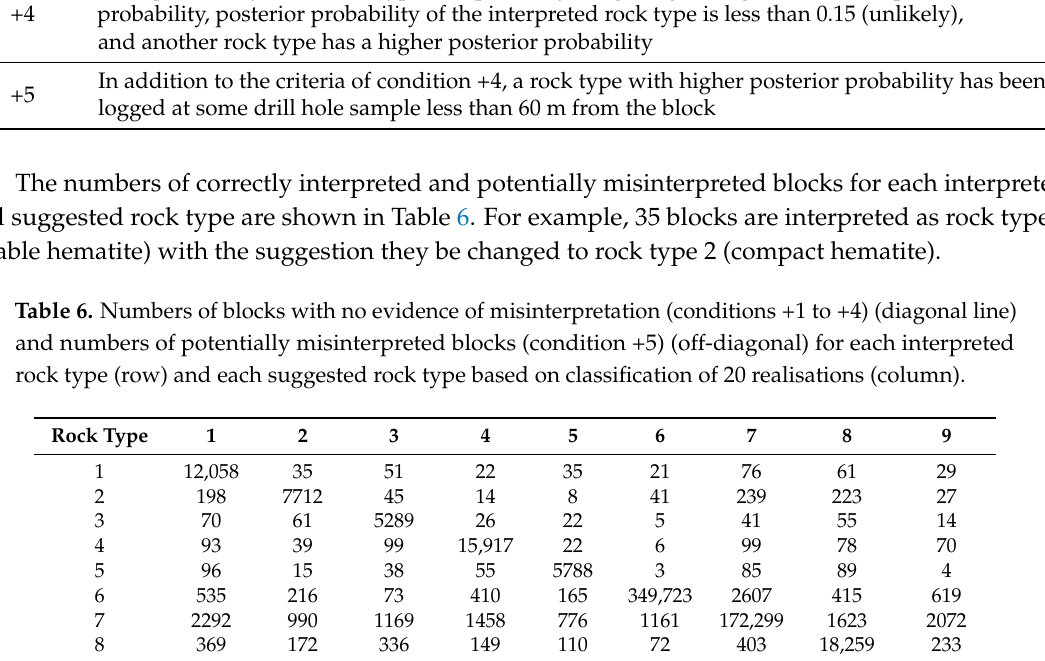
Table 6. Numbers of blocks with no evidence of misinterpretation (conditions +1 to +4) (diagonal line) rock type (row) and each suggested rock type based on classification of 20 realisations (column).